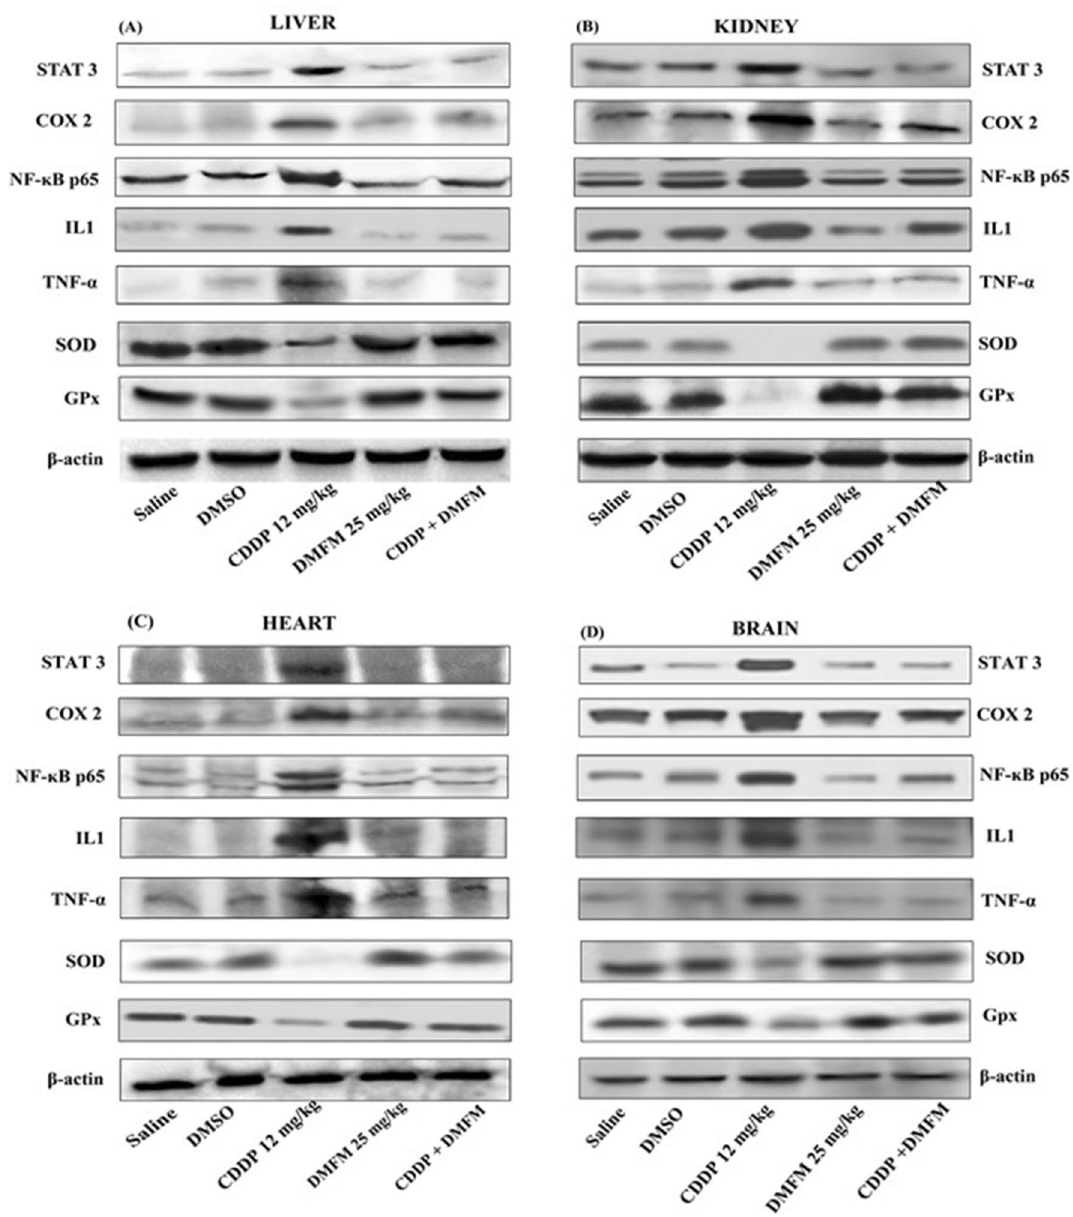
Figure 6. Protein immunoblotting analysis of tissue lysates prepared from ( A ) Kidney, ( B ) Liver, ( C ) Heart, and ( D ) Brain tissues treated with CDDP (12 mg/kg) and DMFM (25 mg/kg) or equal amount of DMSO as described in the experiment section. Groups are designated below the blots. Uncropped blots are included in Supplementary Fig. gen bond acceptors were measured, as well as 8 rotatable bonds. The negative and positive ionizable elements were 0 and 2, respectively. The cLog P value of DMFM was estimated as 3.021. Molecular dynamic simulation. All the docked systems were subjected to molecular dynamics simu- lations to investigate the stability of the interaction between drug and drug targets. The root means square fluctuation (RMSF) of COX2, IL-1, SOD, GPx, NF-κB, P65, STAT3, iNOS, and TNF-α systems were calculated to measure the fluctuations of all the protein C-alpha atoms. All the systems showed stability throughout the simulations in the dynamic trajectories generated at 30 ns (Fig. 13). COX2 dynamic trajectories showed stability in the region comprising binding residues. Fluctuations were observed at regions ranging from 37–64, 113–136, and 190–208 with an RMSF value of 5.6 (Fig. 13A). Dynamic simulation analysis of GPx revealed fluctuation at diverse regions of the protein ranging from residues 1–8 and 92–106 with RMSF value 6. Interestingly, all the residues critical for drug binding showed stability in their behavior (Fig. 13B). Analysis of the IL-1 system showed fluctuation in the region of amino acids 133–145 of